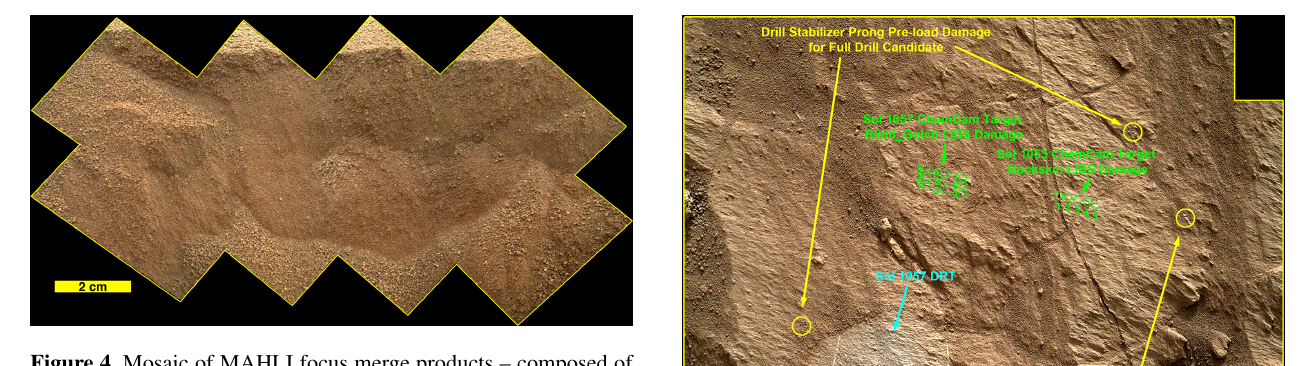
Figure 4. Mosaic of MAHLI focus merge products – composed of images acquired on sol 802 (8 November 2014) – covering a surface cut by scuffing Curiosity’s right front wheel into an eolian bedform on sol 799 (5 November 2014). Illuminated by the Sun from the top/left (thus the wheel scuff wall is in shadow), this is a com-